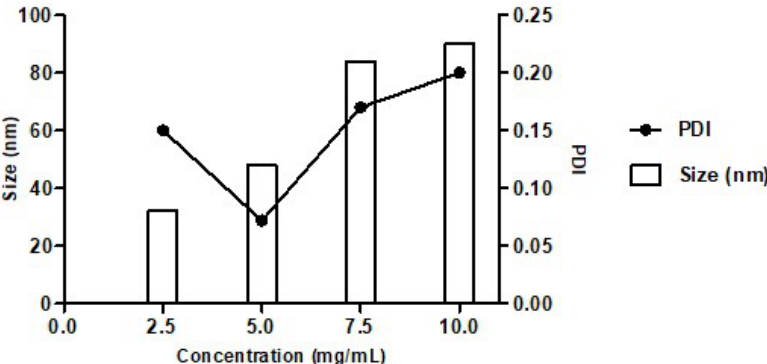
Figure 3. Variation of hydrodynamic diameter and PDI of PdiMeMLA 54 - b -PdiMeMLAHe 29 based NPs with di ff erent final concentrations in water.